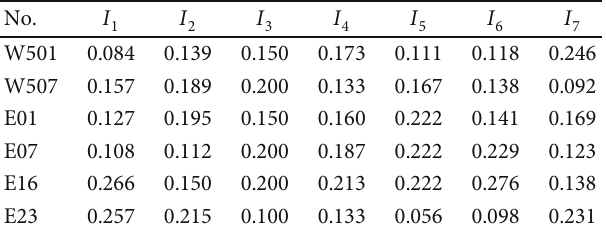
Table 4: Normalized index matrix.